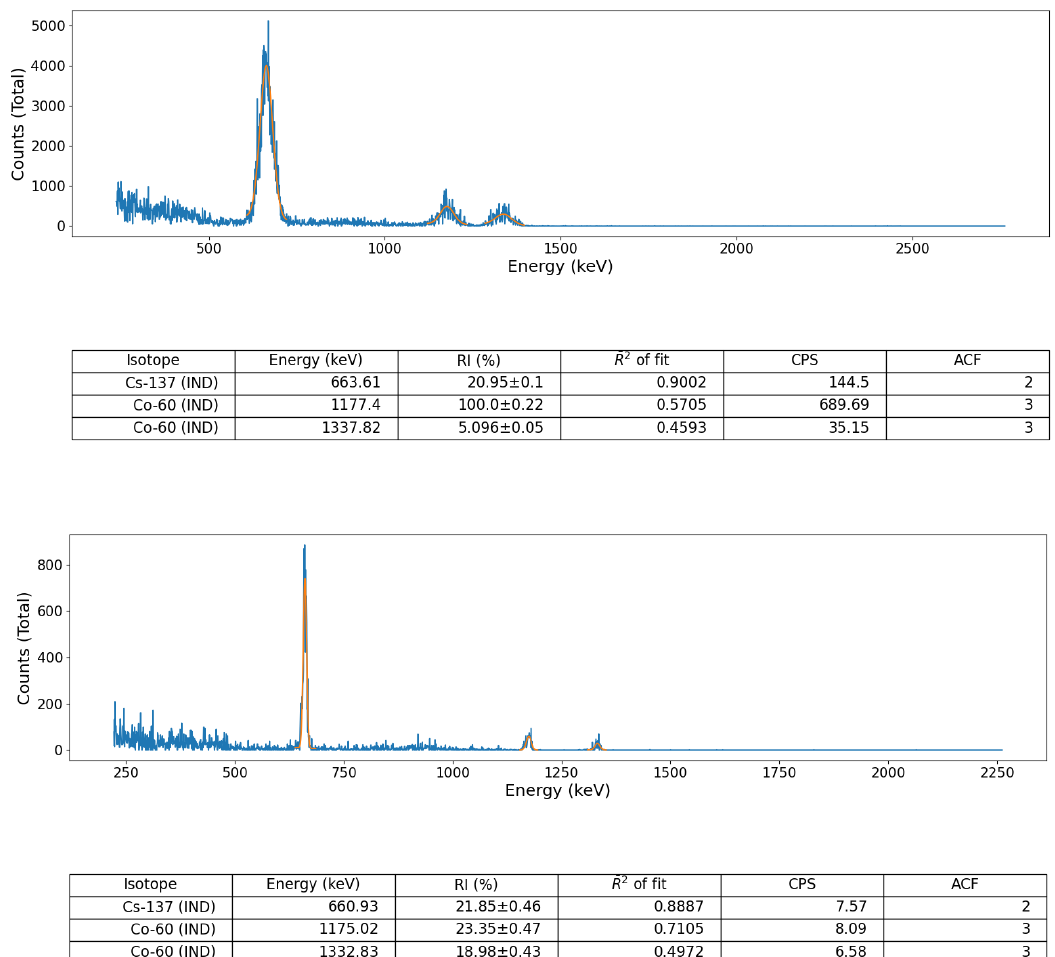
Figure 7. Peak-identified gamma-ray spectra, derived online (live), for a Eckert and Ziegler™ multi-radionuclide gamma-ray calibration source (emitters detailed in Table 1). Collected